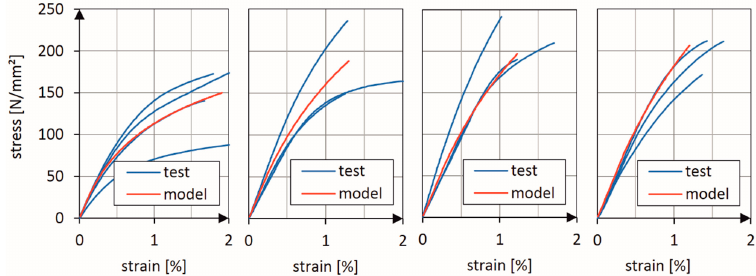
Figure 6. Comparison of measured and predicted stress-strain curves for material configuration (b), layup: 9 layers ±30° (2D biaxial braid), for four different strain rates: 2 mm/min, 10 mm/s, 100 mm/s and 1000 mm/s (from left to right). Table 2. Strain rate parameters and model parameters.